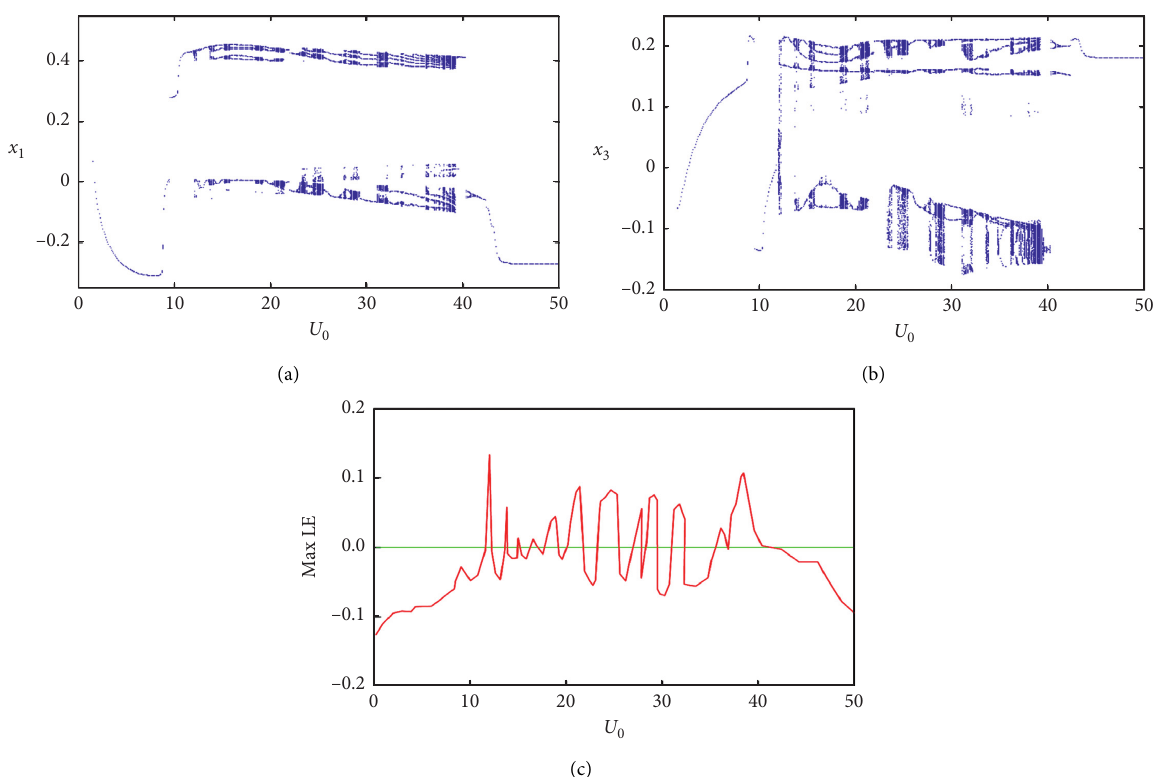
Figure 7: The bifurcation diagrams and maximum Lyapunov exponents of the cantilevered pipe conveying pulsating fluid are given for the parametric excitations of the flow velocities when the external excitation is F � 7. (a) x (c) maximum Lyapunov exponents versus flow